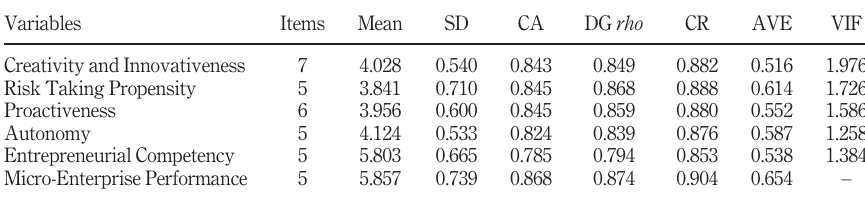
Table II. Reliability and validity